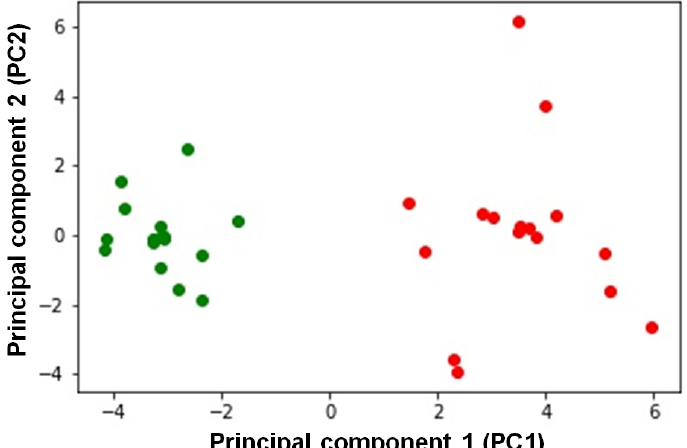
Figure 5. Principal component analysis. The figure reports the projection onto the first two principal components of the analyzed dataset. CT subjects are represented by green circles, while OC subjects are represented by red circles. For the analysis, the following parameters were used: complex I, cytochrome c oxidase, citrate synthase, complexes II + III, ATP hydrolase and citrate synthase activities, SIRT3/β-actin, PHB2/β-actin, COXIV/β-actin, cAMP level, L-OPA1/β-actin, S-OPA1/β-actin, S*-OPA1/β-actin, L- + S- + S*-OPA1/β-actin, % L-OPA1, % S-OPA1, % S*-OPA1, TFAM/β-actin, PGC1α/β-actin, mtDNA content, RII-PKA/β-actin, C-PKA/β-actin, RII-PKA/C-PKA, mitochondria number, and mitochondrial length. See Section 4 for details.